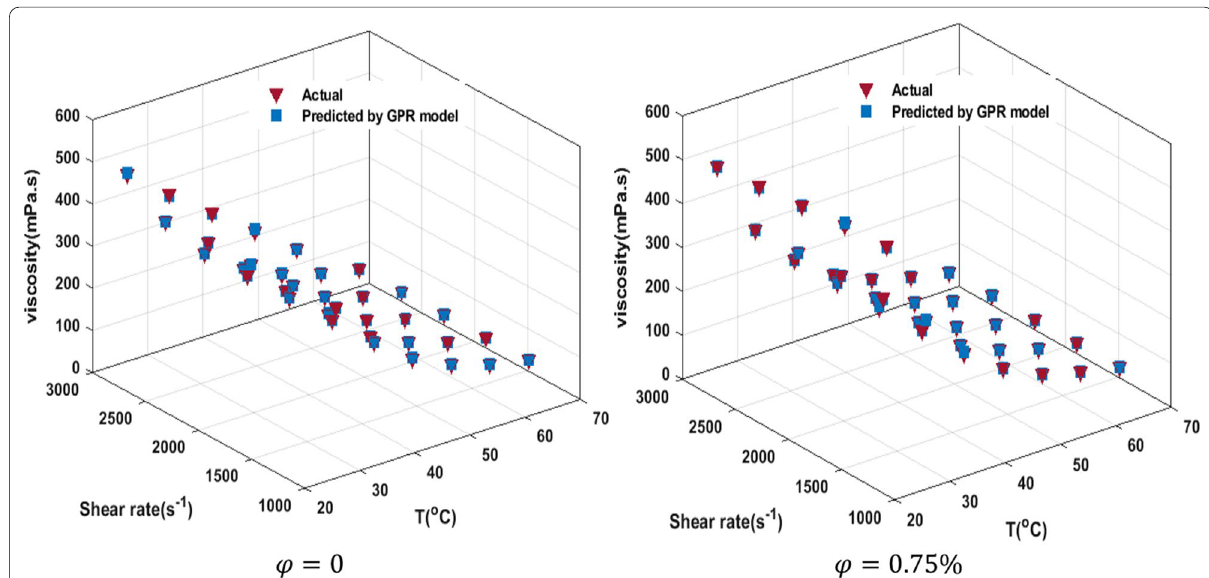
Fig. 20 Comparison of estimated data by GPR model with experimental